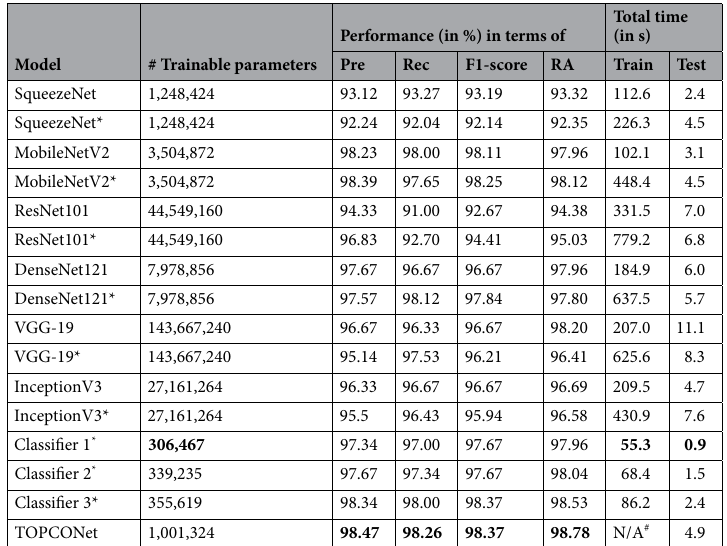
Table 2. Performance comparison of the proposed 3 base classifiers and TOPCONet with some state-of-the- art CNN models utilising the concept of transfer learning and training from scratch on Dataset-1. For citing recall (Rec), precision (Pre) and F1-score micro-average method is used. *After the CNN models’ name means that the models have been trained from scratch. # As the proposed ensemble method is non trainable, hence time required to run on the training split is not applicable (N/A). RA indicates recognition accuracy and bold faced numbers indicate the best scores.